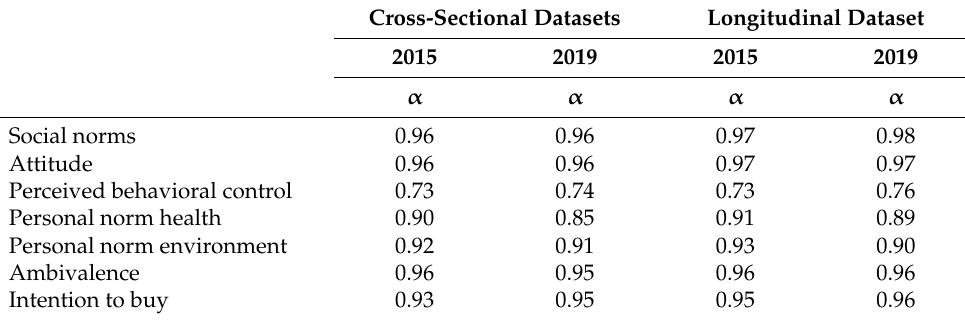
Table 1. Cronbach’s alphas for constructs of both